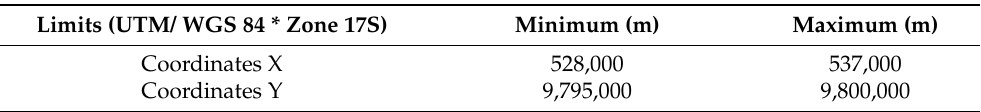
Figure 5. GeoModeller software process creation model. Table 1. Coordinates of the study area. * UTM: Universal Transverse Mercator/WGS 84: World Geodetic System